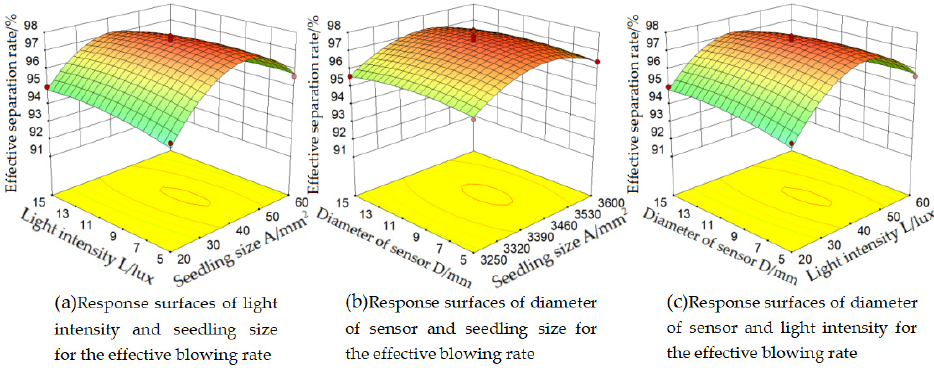
Figure 7. Response surfaces of two factors for the effective blowing rate.